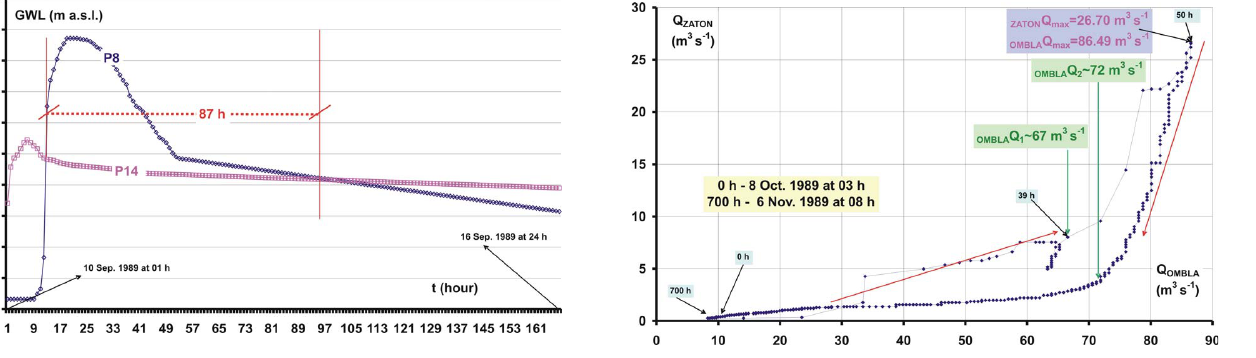
Figure 6 Fig. 6. Time data series of hourly GWL measured by piezometers Figure 7 Fig. 7. Relationship between hourly discharges of the Ombla and P8 and P14 during high water caused by intensive precipitation. Zaton springs (modified according Bonacci,